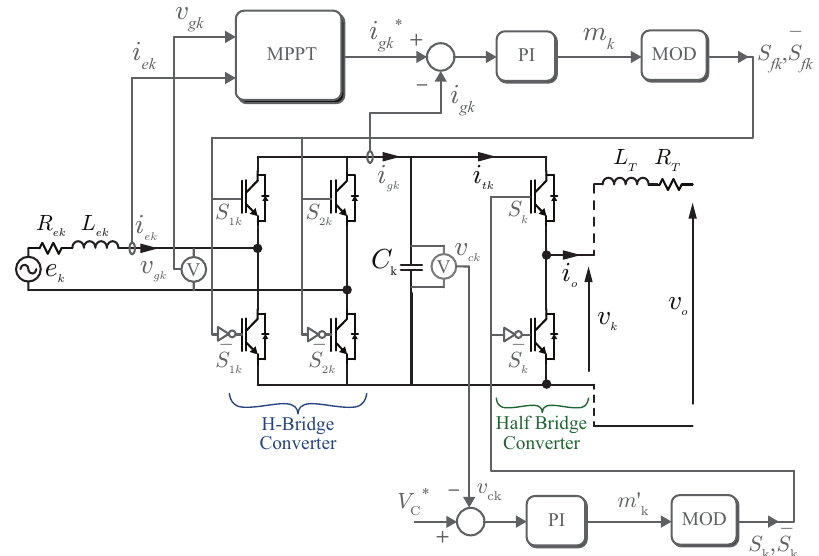
Figure 6. Control scheme and electronic circuit of an MMC